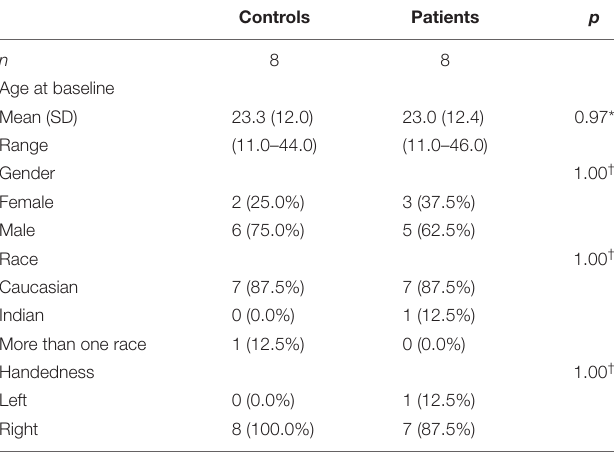
TABLE 2 | Statistical comparison of the RPE65 patients and sighted